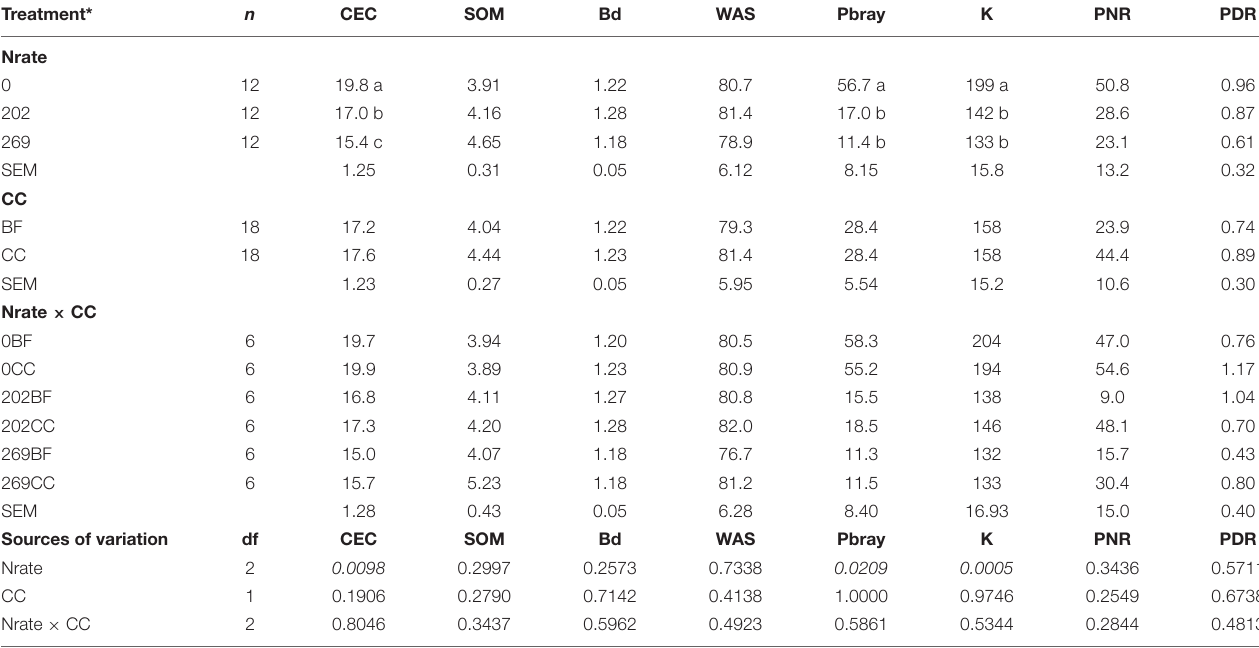
TABLE 1 | Estimated treatment means, standard errors of the mean values (SEM), and sample size ( n ) of selected soil chemical properties, including cation exchange capacity (CEC, cmol c /kg), soil organic matter (SOM,%), bulk density (Bd, Mg/m 3 ), water aggregate stability (WAS,%), available phosphorus (Pbray, mg/kg), and extractable potassium (K, mg/kg), along with the potential nitrification (PNR, mg N/kg dry soil day), and denitrification (PDR, ng N/g dry soil hr) rates determined under the N fertilization (Nrate) and cover cropping (CC) treatments, and their